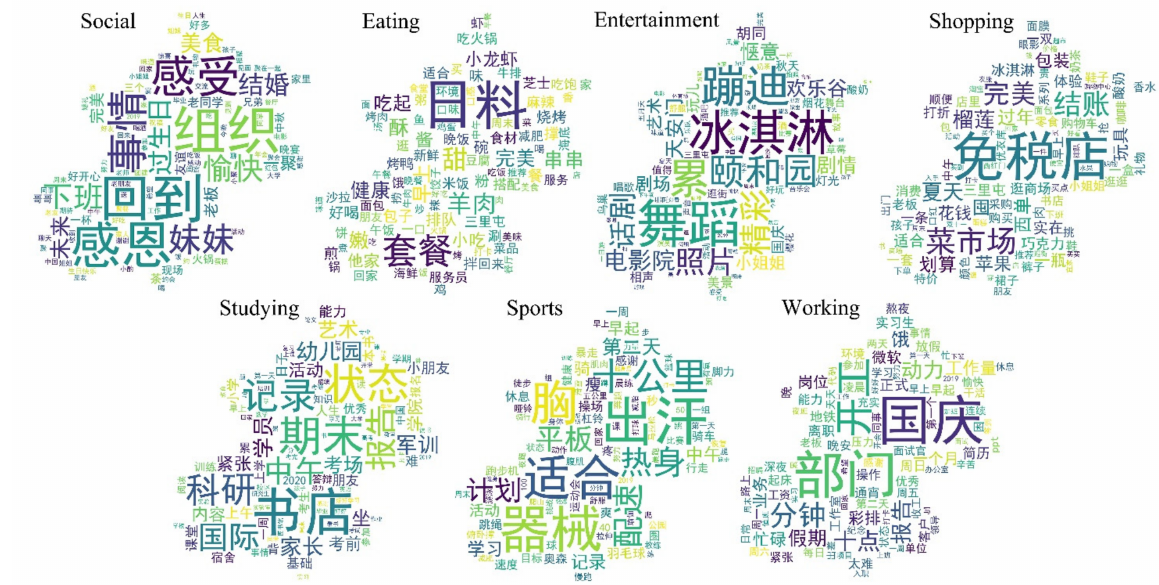
Figure 3. Word clouds for various types of resident